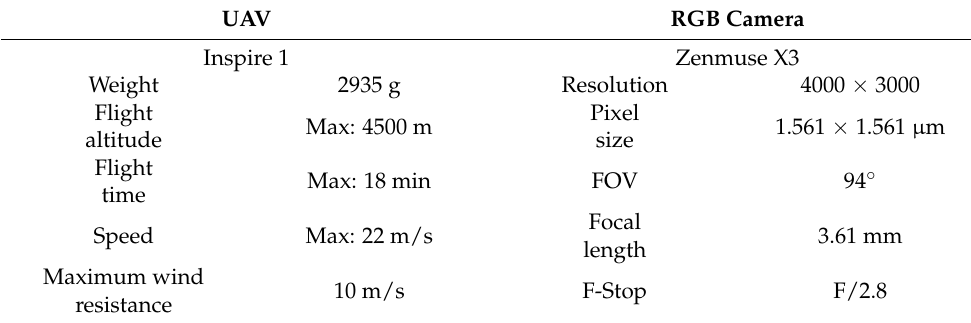
Table 1. Specifications of Inspire 1 and Zenmuse X3.